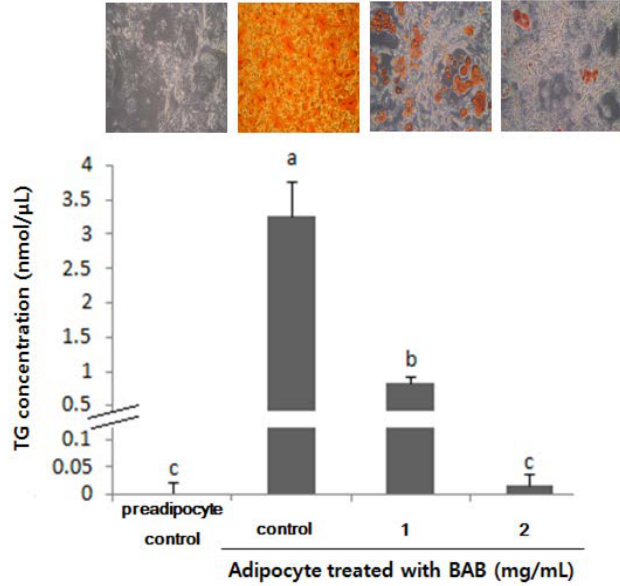
Figure 5. Effects of black adzuki bean extract on lipid accumulation in 3T3-L1 cells. 3T3-L1 preadipocyte and differentiated adipocytes treated with black adzuki bean extract (0 to 2 mg/mL) were incubated for 11 days. Cells were stained with Oil Red O and observed under the microscope. Data are expressed as means ± SD and a different letter indicates a significant difference among cells treated with black adzuki bean, according to ANOVA with Duncan’s multiple range test ( p <